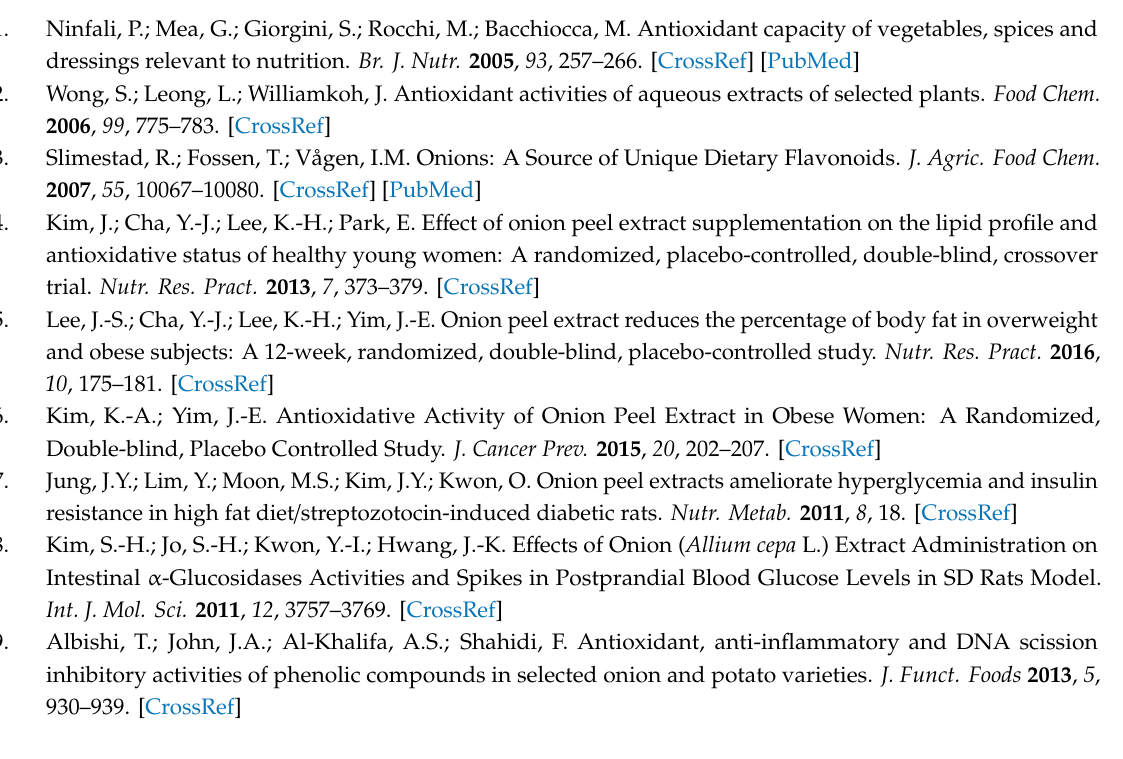
Figure S1: The TGA curve shows three steps: the first one until 200 ◦ C corresponding to the vaporization of residual water (13.6%), the second step until 500 ◦ C due to the decomposition of the organic components, the third one above 500 ◦ C characterized by a mineral residue (22.78%) due to bentonite content. Figure S2. PVP K90 shows a broad endothermic peak between 45 and 120 ◦ C due to the evaporation of bound water or moisture. For bentonite it is detectable a broad band between 60 and 100 ◦ C attributable to adsorbed water loss. NaCMC shows a glass transition temperature (Tg) at 75 ◦ C, corresponding and an exothermic peak at 284 ◦ C due to the melting and the crystallization transition. Pre OLE thermogram shows that thermal process occurs at 80 ◦ C probably related to the loss of volatile constituent of the sample (ethanol). No thermal decomposition was observed in the temperature range investigated. For the hydrogel film B2 a glass transition temperature (Tg) at 228 ◦ C was observed. The spectra are shown in arbitrary units (a.u.) and shifted for clarity. Figure S3. Swelling % and erosion % of the hydrogel film B2 in SWF thermostated at 32 ◦ C for 480 min. Table S1. Hydrogels compositions. Table S2. Compositions of hydrogels loaded with di ff erent OLE percentages. Table S3. Bacterial strains and growth